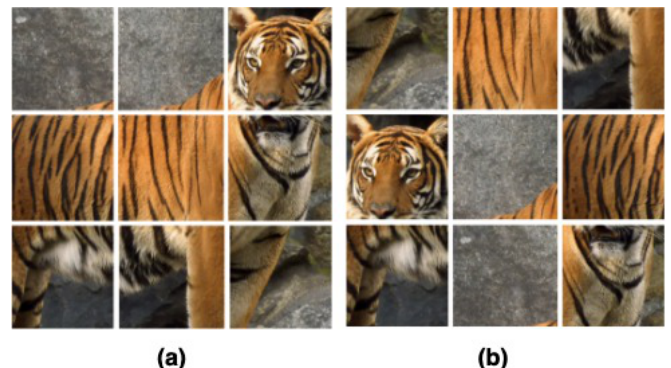
Figure 6. Solving jigsaw puzzle being used as a pretext task to learn representation. ( a ) Original Image; ( b ) reshuffled image. The original image is the anchor and the reshuffled image is the posi- tive